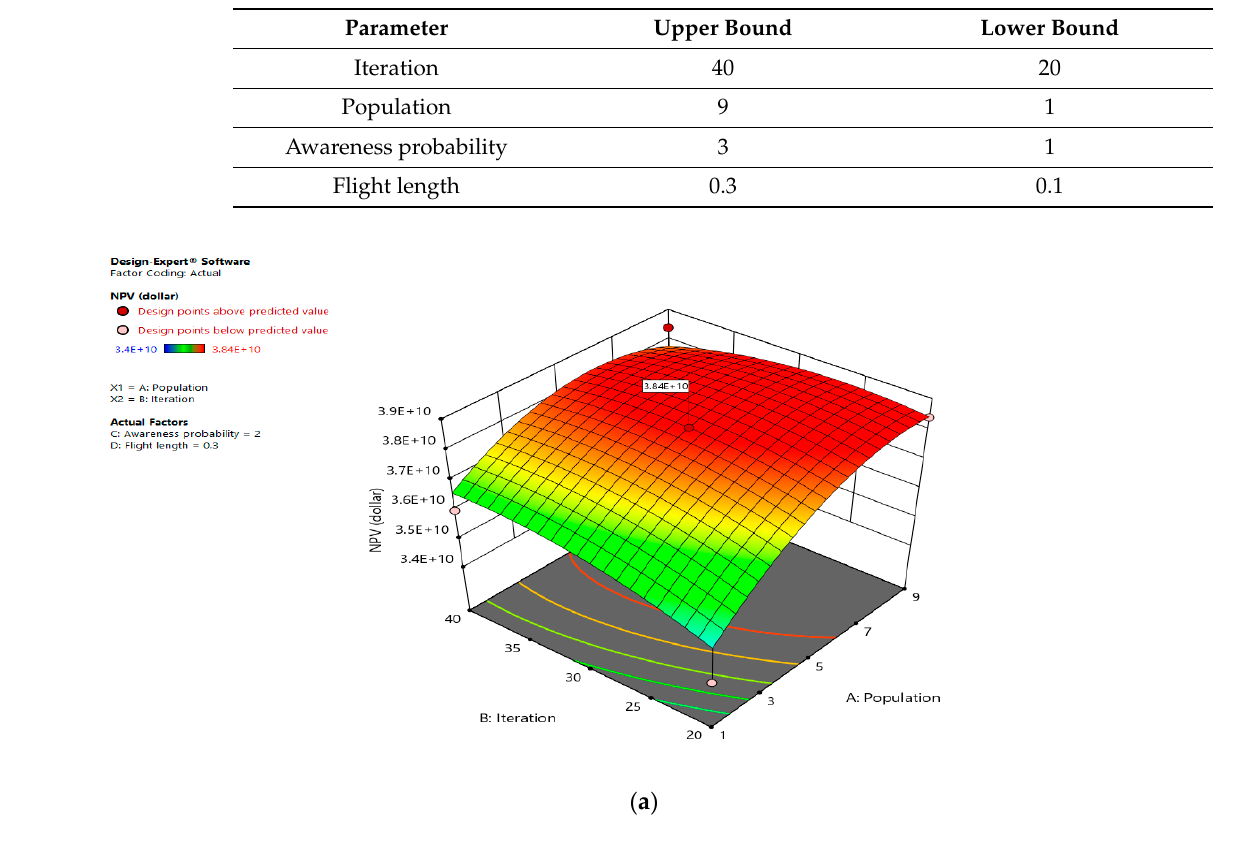
Table 10. Statistical data of applied metaheuristic algorithms on well placement optimization for the case study 1 reservoir.